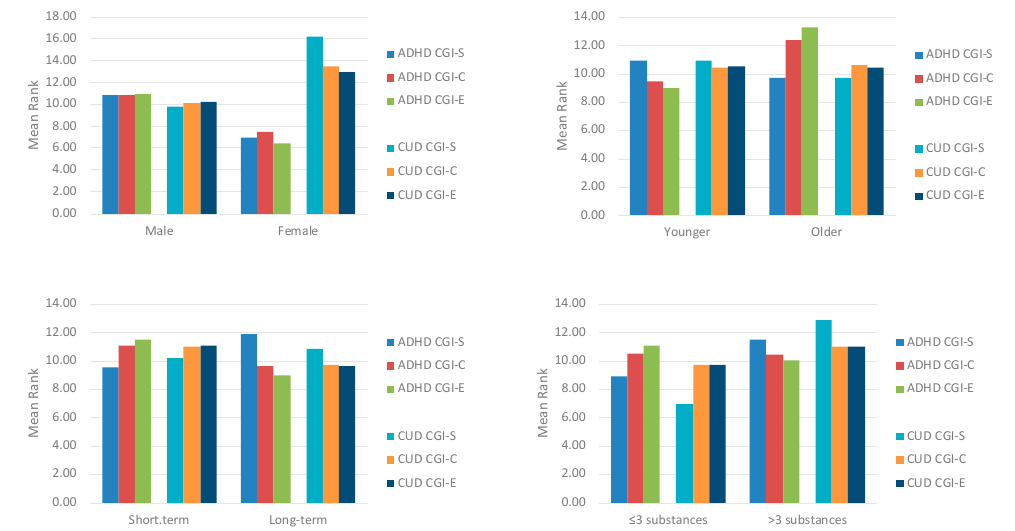
Figure 1. Relationship between CGI outcomes and other clinical aspects; CGI = Clinical Global Impression; ADHD CGI-S = Attention Deficit Hyperactive Disorder Severity of illness; ADHD CGI-C = Attention Deficit Hyperactive Disorder Change; ADHD CGI-E = Attention Deficit Hyperactive Disorder Efficacy; CUD CGI-S = Cocaine Use Disorder Severity of illness; CUD CGI-C = Cocaine Use Disorder Change.